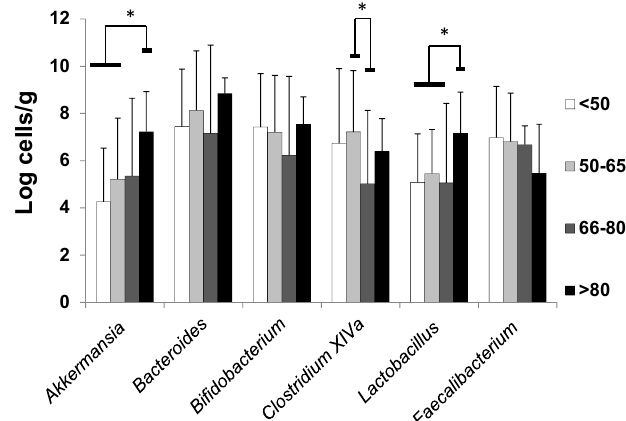
Figure 1. Bacterial levels (log cells/g, estimated marginal mean ± SD) of the microbial groups analyzed in the different age groups. Results were adjusted by energy intake, gender and BMI. * Denotes statistically significant differences ( p < 0.05) among the indicated age groups.